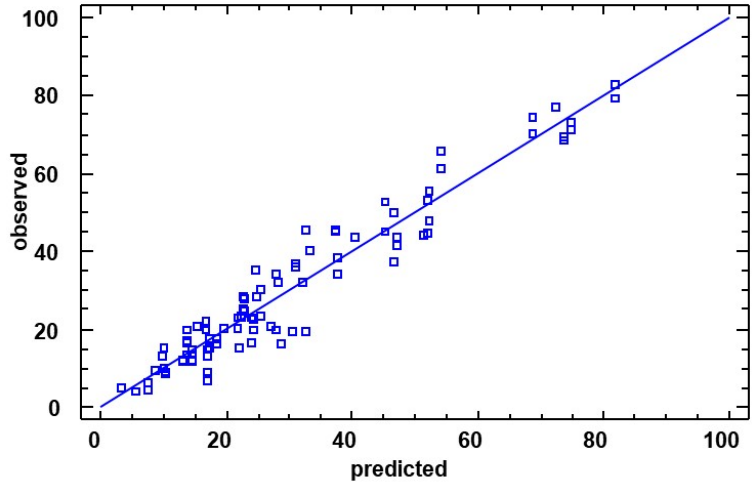
Figure 1. Bioethanol yield observed versus predicted by Equation